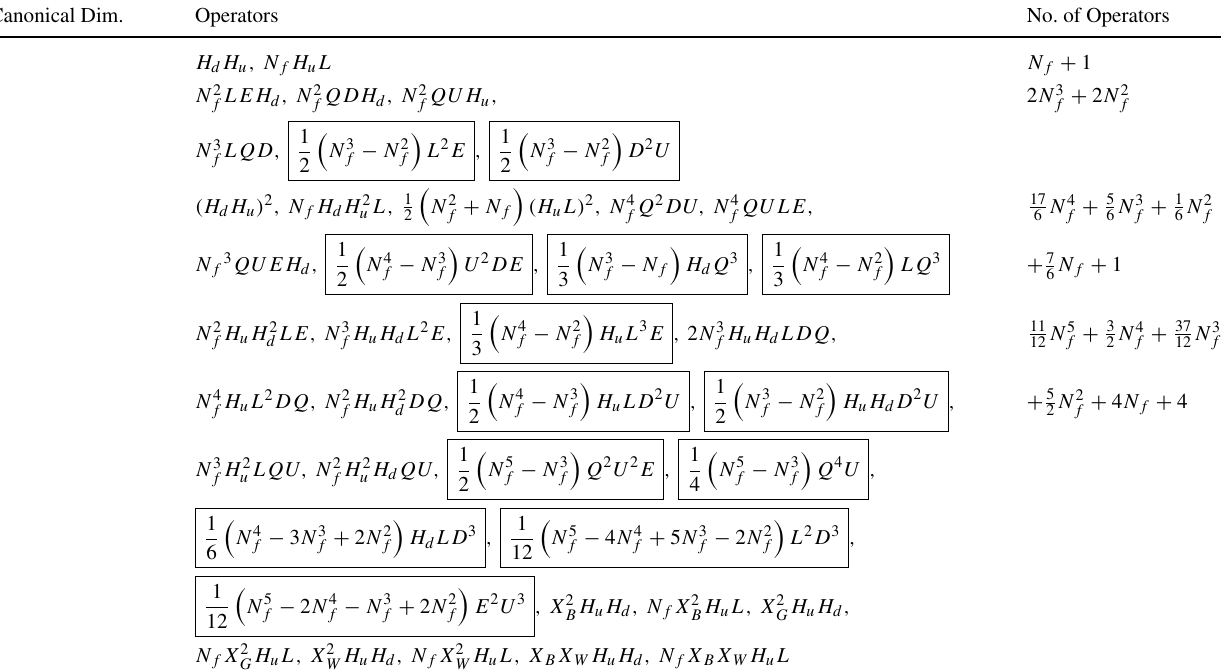
Table 24 MSSM: Operators composed solely of chiral superfields. X B , X W , X G are field strength tensors corresponding to the vector superfields B , W and G . Boxed operators vanish for N f = 1 Canonical Dim.